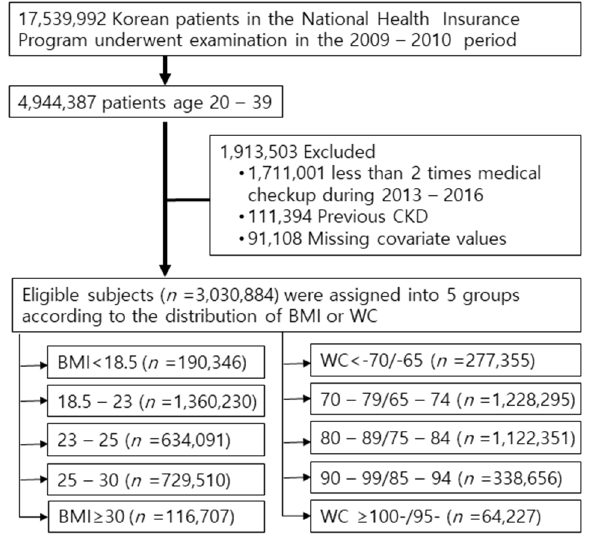
Figure 1. Flow diagram of the study. Abbreviations: CKD, chronic kidney disease; BMI, body mass index; WC, waist circumference.